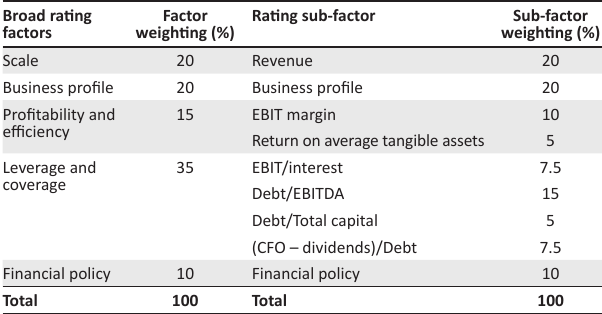
TABLE 3: Moody’s mining methodology.